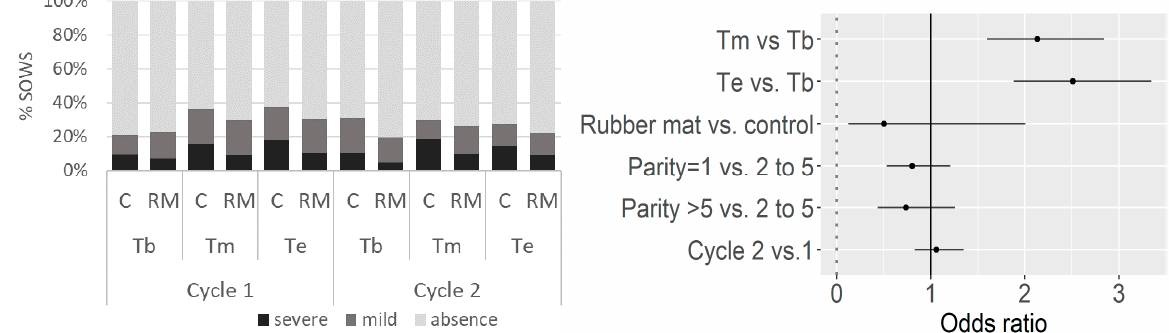
Figure 2. Frequencies of observed lameness and estimated odds ratios (with 95% confidence intervals) according to the floor type and gestation cycle, from the beginning (Tb) to the middle (Tm) and end (Te) of the gestation period. RM, rubber mat; C, control.